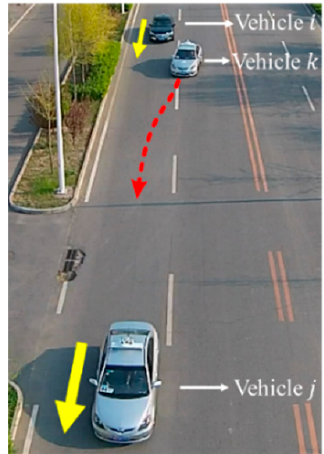
Figure 7. Actual scenario. The experiment site is a flat road on the outskirts of Beijing, which is in good road condition and surrounded by no other vehicles.